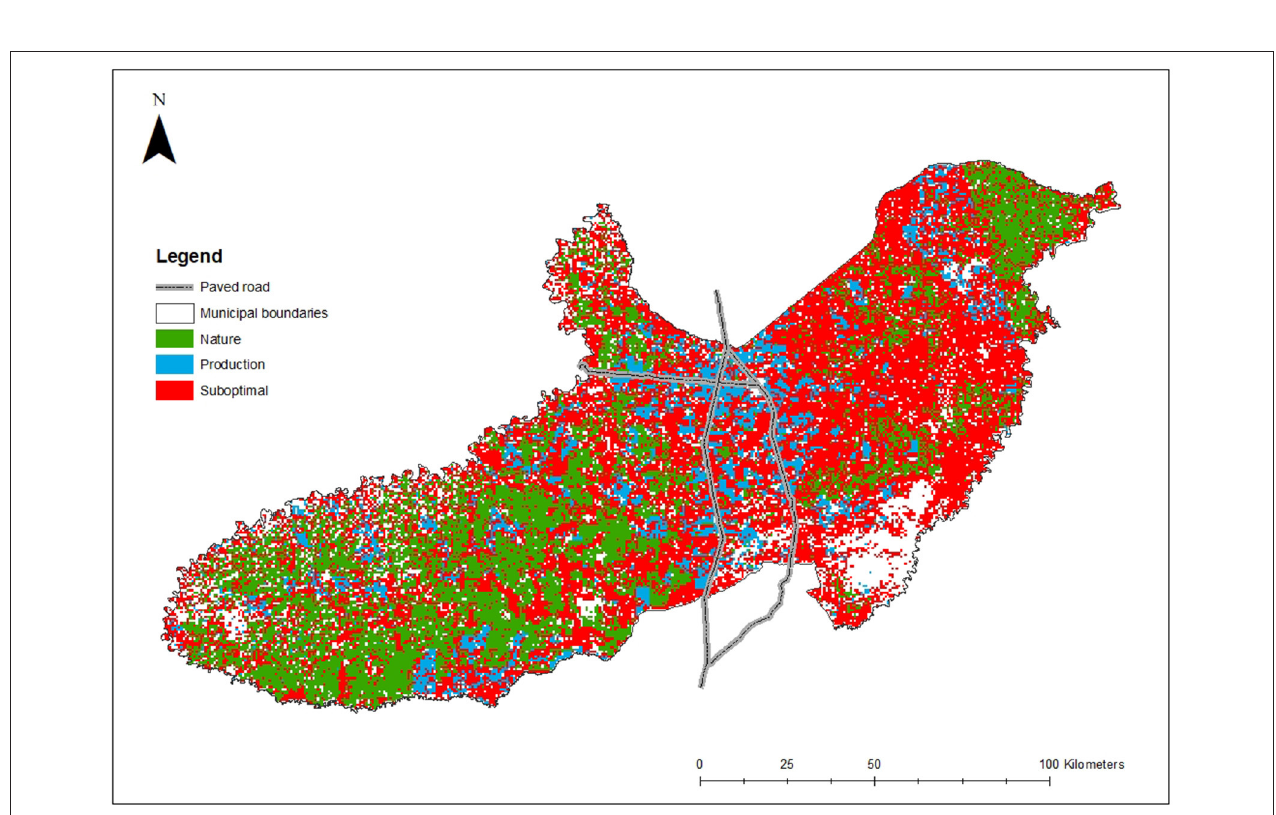
FIGURE 6 | Areas of potential (mis)matches and trade-offs between ecosystem services according to pedo-morphological units and land uses in Paragominas.